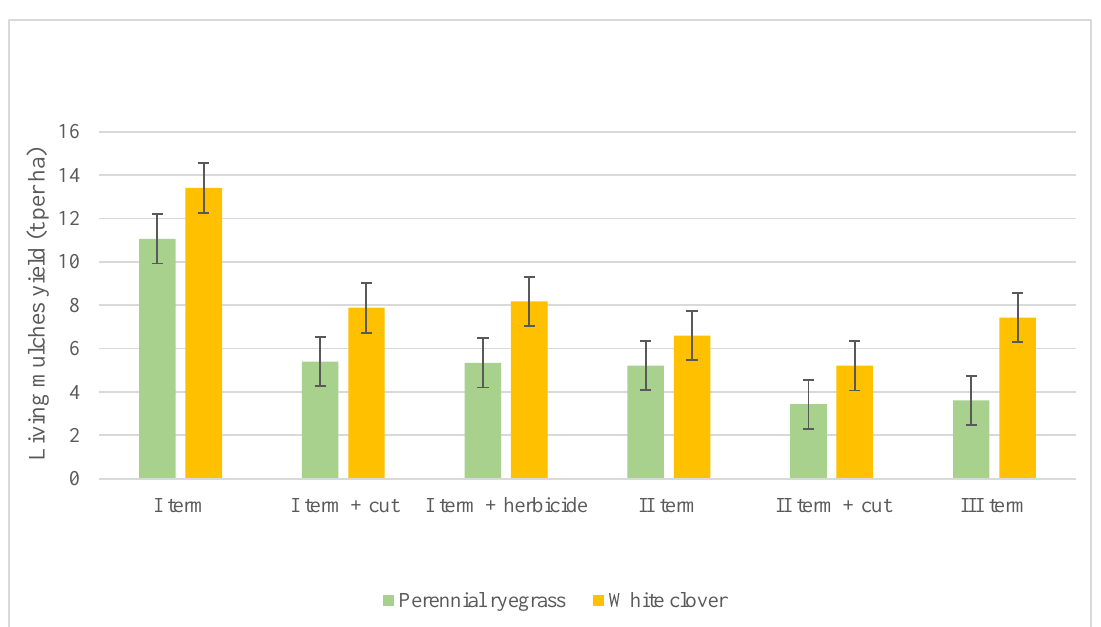
Figure 2. Living mulches biomass dependence on living mulches species, sowing term and management [t·ha − 1 ]. I term — living mulches sowed 3 weeks before planting eggplants; II term — living mulches sowed on the day of eggplants planting; III term — living mulches sowed 3 weeks after eggplants planting.